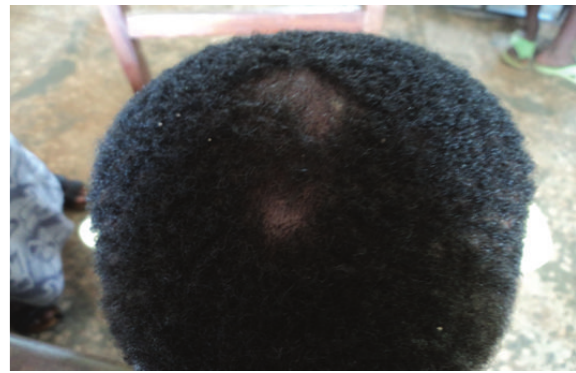
Figure 6: Tinea capitis with alopecia.